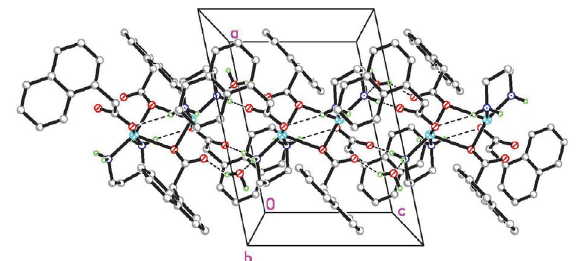
Figure 4. Molecular packing of 2 · 2H 2 O, viewed along the b axis. Hydrogen bonds are drawn as dashed lines. Hydrogen atoms not related to hydrogen bonds are omitted for clarity.